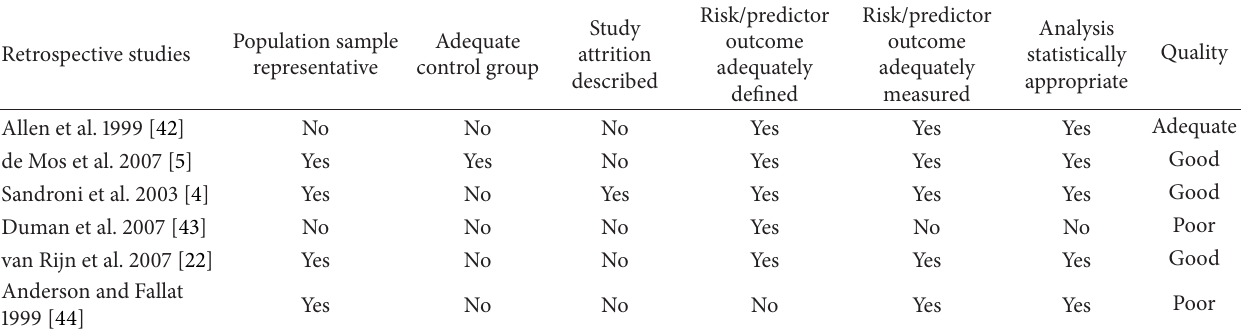
Table 6: Results presenting quality and relevance of data extraction for onset of CRPS 1 from retrospective